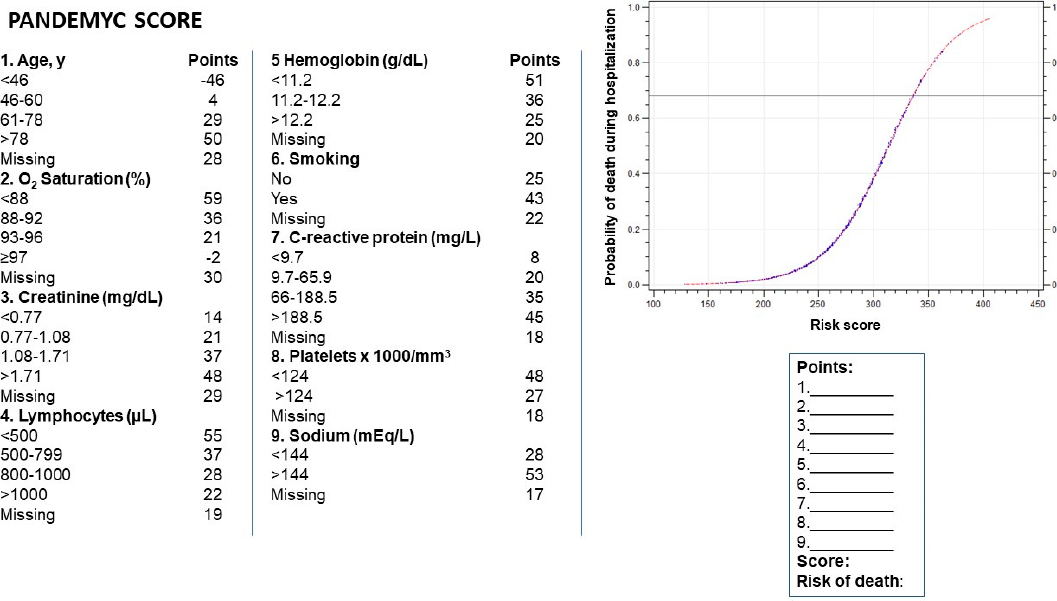
Figure 1. Resulting score for each variable during the discretization process. The mortality risk is calculated by summing the points for each variable.